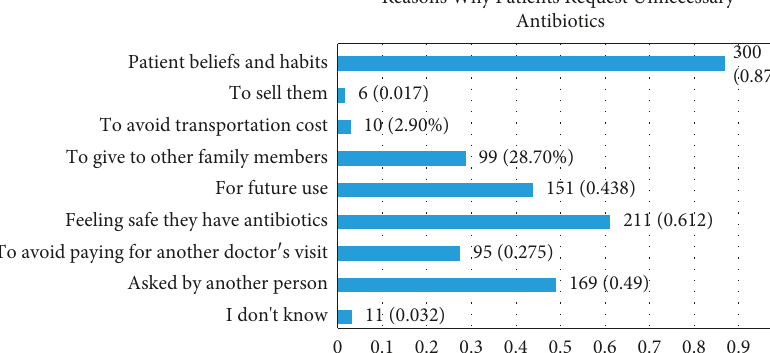
Figure 2: Percentage of responses selected by dentists as possible reasons why patients may ask dentists to prescribe unnecessary antibiotics (dentists could select more than one